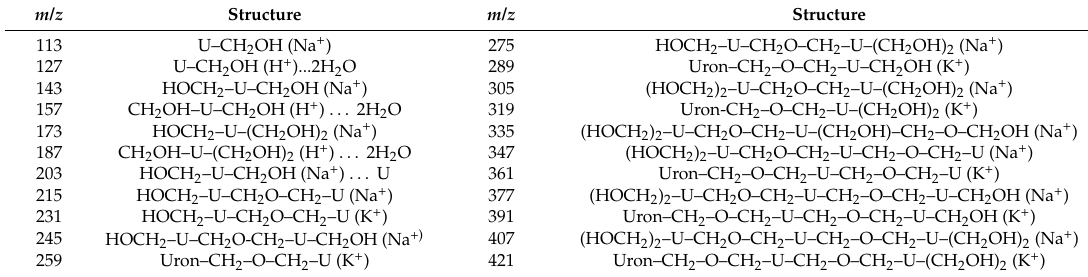
Table 2. Assignment for the electrospray ionization mass spectrometry (ESI–MS) peaks of UF reaction products at first alkaline stage (Sample